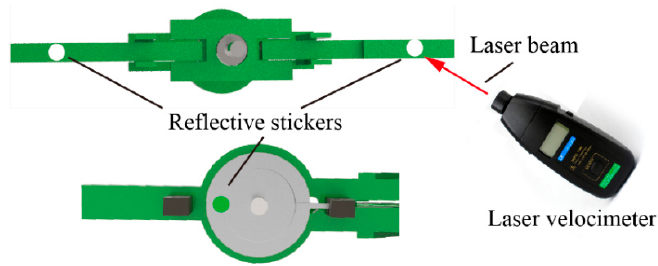
Figure 4. Measurement of flapping frequency and rotational speed.